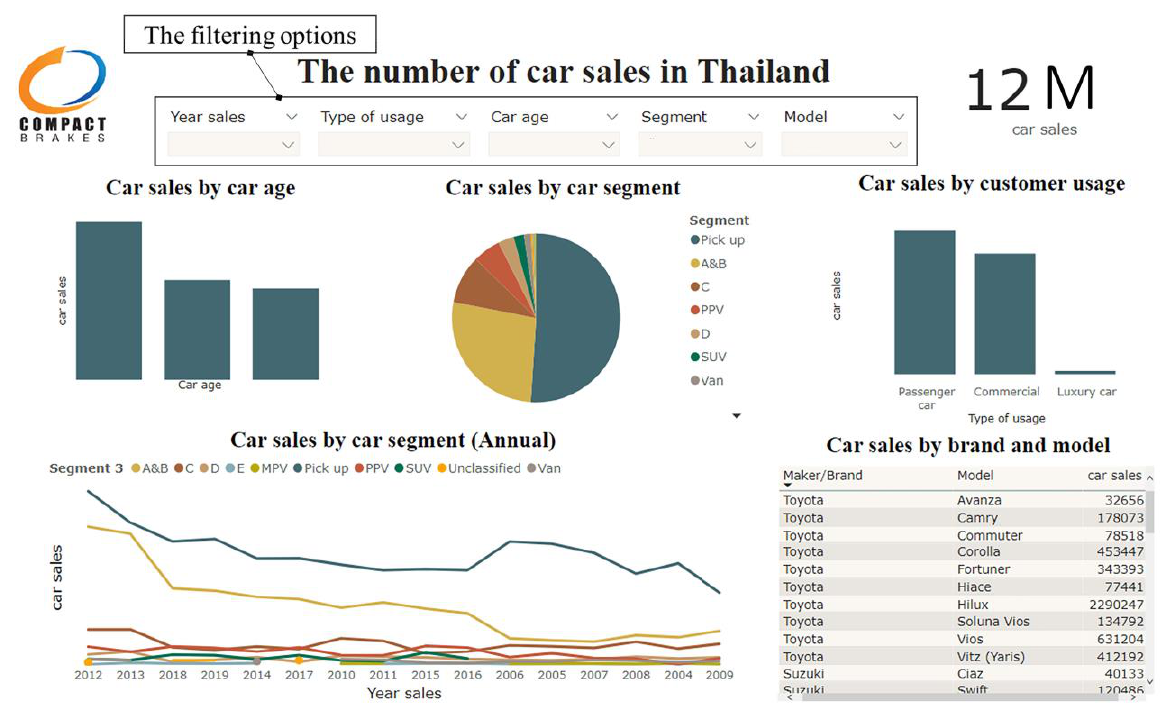
Figure 7. Example of a car sales report with business